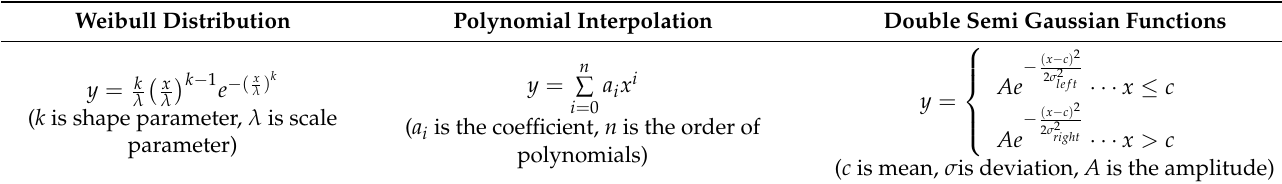
Table 2. The formulas of some asymmetric functions.